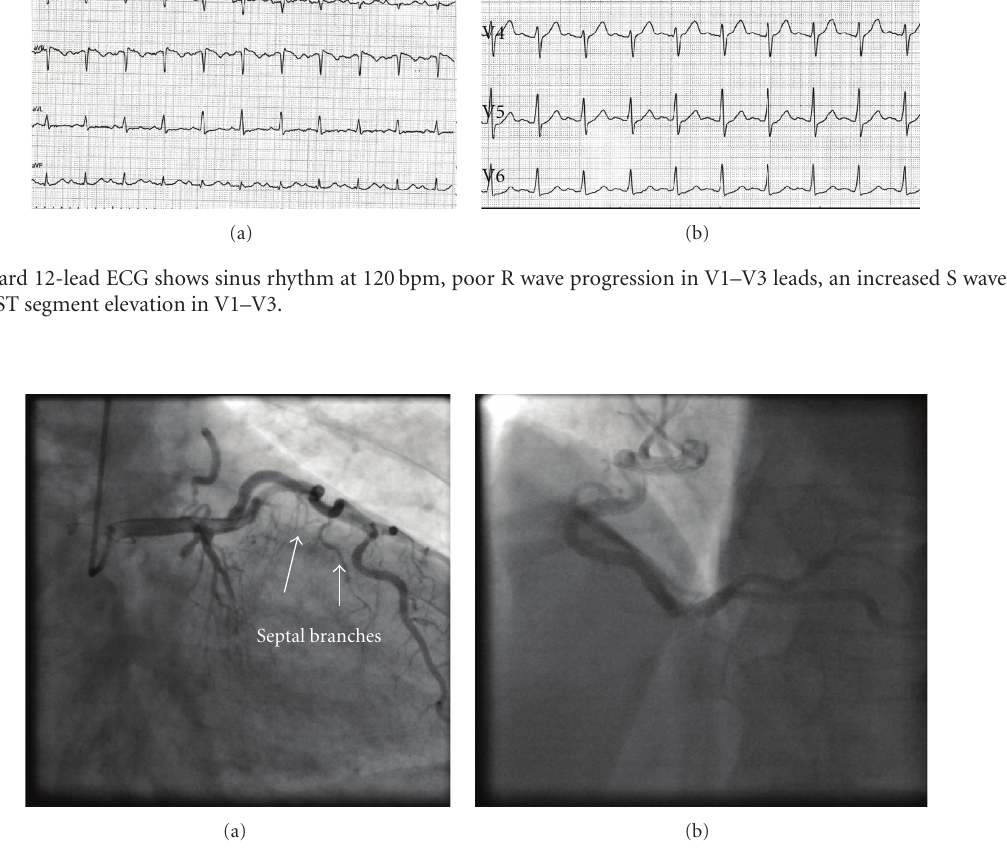
Figure 2: A coronary angiogram shows coronary fistula from the left anterior descendens (LADs) into the pulmonary artery (a) without significant coronary stenosis. (b) Right coronary artery.